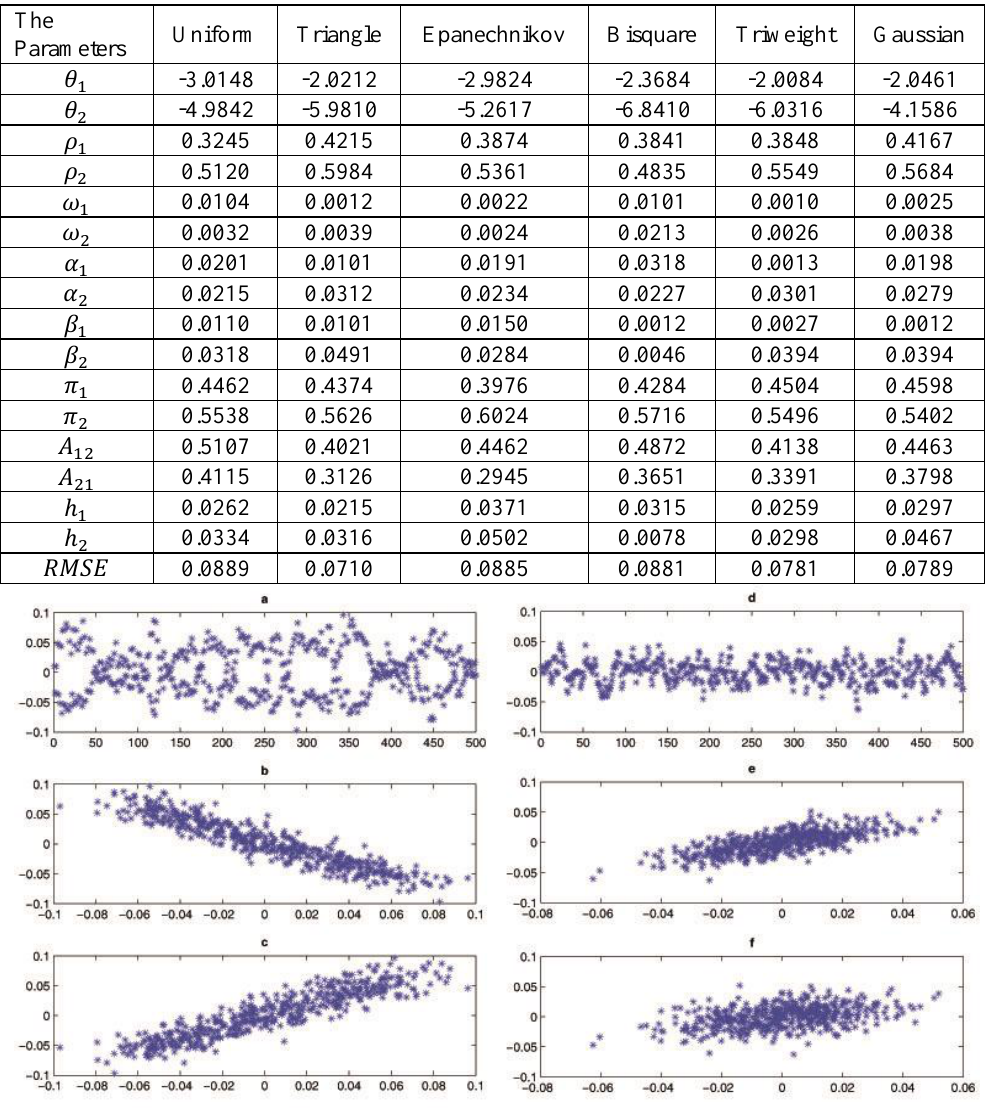
Table 2. The estimated parameters for the simulated data based on ( ) ( ) . The Uniform Triangle Epanechnikov Parameters